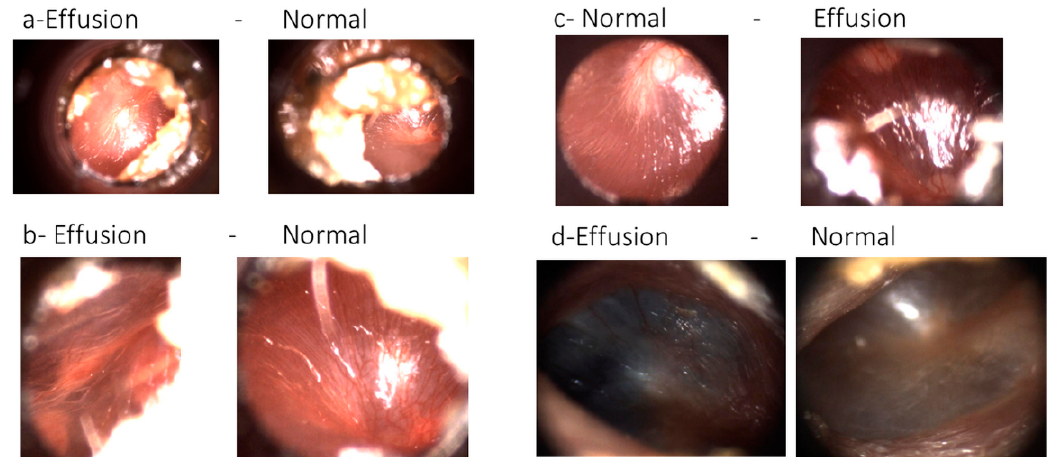
Figure 6. Examples of pair misclassified eardrum images labeled as subtle. Images are shown with the left ear on the right and right ear on the left. ( a ) Effusion(right ear)-Normal(left ear), ( b ) Effusion(right ear)-Normal(left ear), ( c ) Normal(right ear)-Effusion(left ear), ( d ) Effusion(right ear)-Normal(left ear).